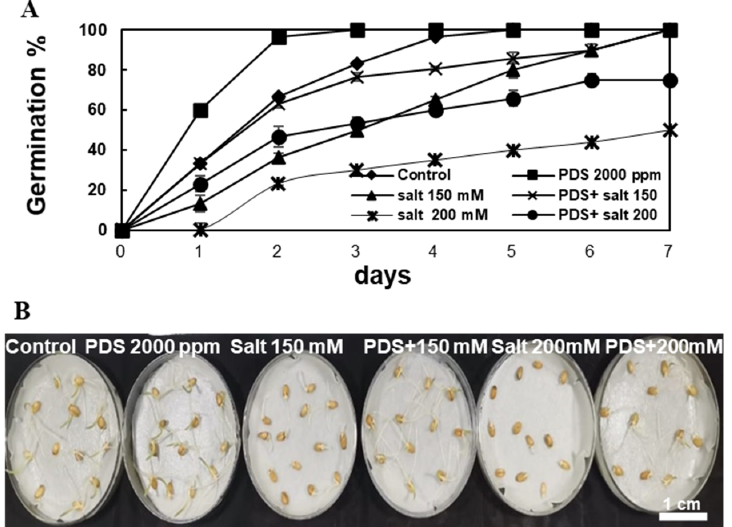
Figure 1. Effect of PDS on germination rate of wheat under normal and salt stress conditions. ( A ) Wheat seeds were subjected to PDS 2000 ppm, salt 150 and 200 mM and PDS + salt treatments (150 + 2000 ppm and 200 + 2000 ppm). Germination rate was observed at day 1–7. PDS 2000 ppm accelerated germination rate and alleviated the salt stress (150 and 200 mM) (Figure 1A). X-axes represent number of days. ( B ) Photographs were taken at day 2 (48 h). All data were analyzed using one-way ANOVA, with multiple comparisons using LSD test at a significance threshold of p ≤ 0.05 ( n = 10). Each independent experiment was repeated three